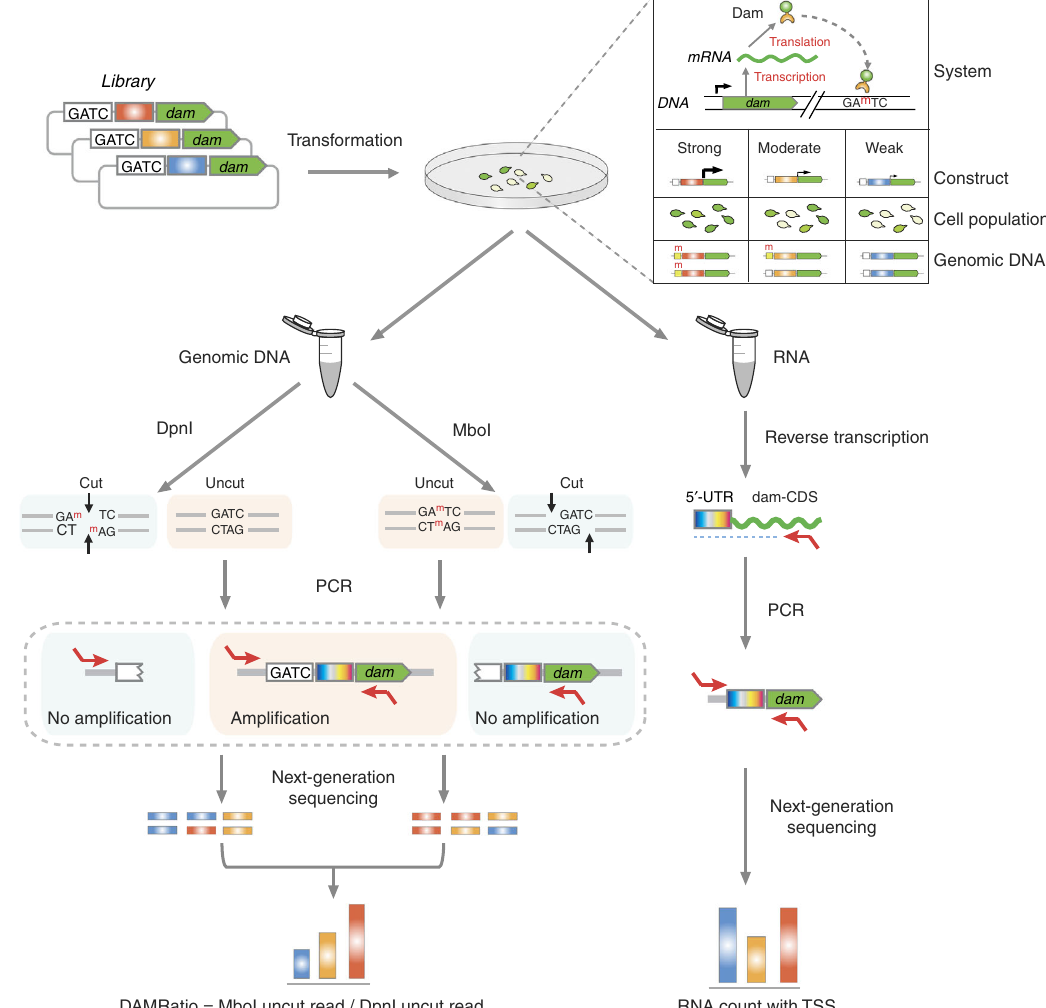
Fig. 1 Work fl ow of ELM-seq — a DNA methylation-based mutational screen of promoters and 5 ′ -UTRs. The expressed Dam protein transfers a methyl group onto the adenine in the GATC motif. Transcription and translation ef fi ciencies control the expression of the Dam protein and consequently the level of adenine methylation. We developed this protocol in M. pneumoniae as follows: we transformed a library of promoter/5 ′ -UTR random constructs containing four GATC sites into M. pneumoniae . We collected genomic DNA and RNA separately. The genomic DNA was digested separately using two distinct methylation-sensitive enzymes (MboI that digests unmethylated GATC sites and DpnI that digests methylated GATC sites). Then we performed PCR reactions that only amplify uncut DNA library fragments, and, in each case, counted the number of reads obtained from next-generation sequencing to determine the so-called DAMRatio. The DAMRatio represents the ratio of the uncut read frequency in the MboI digestion pool to that in the DpnI digestion pool for each random sequence. In the case of mRNAs, the number of reads and TSS were determined for each transcript of our libraries by Dam-speci fi